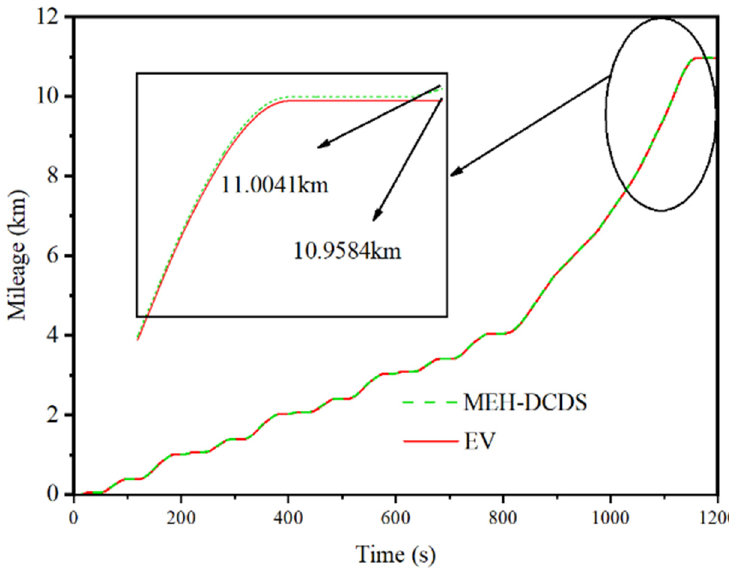
Figure 18. Comparison of mileage.